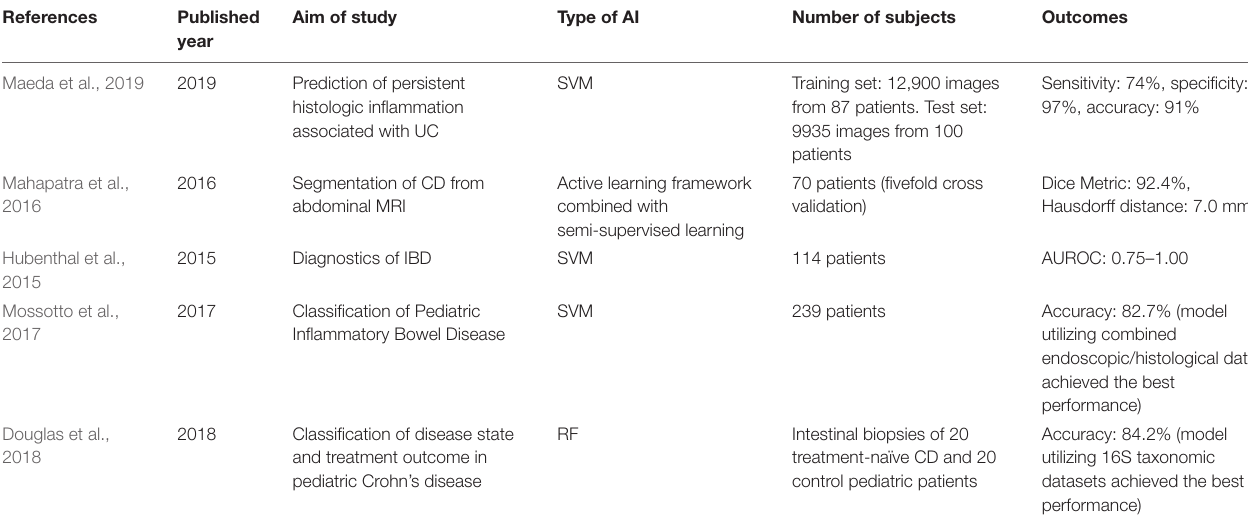
TABLE 2 | Summary of studies using artificial intelligence in IBD diagnosis.